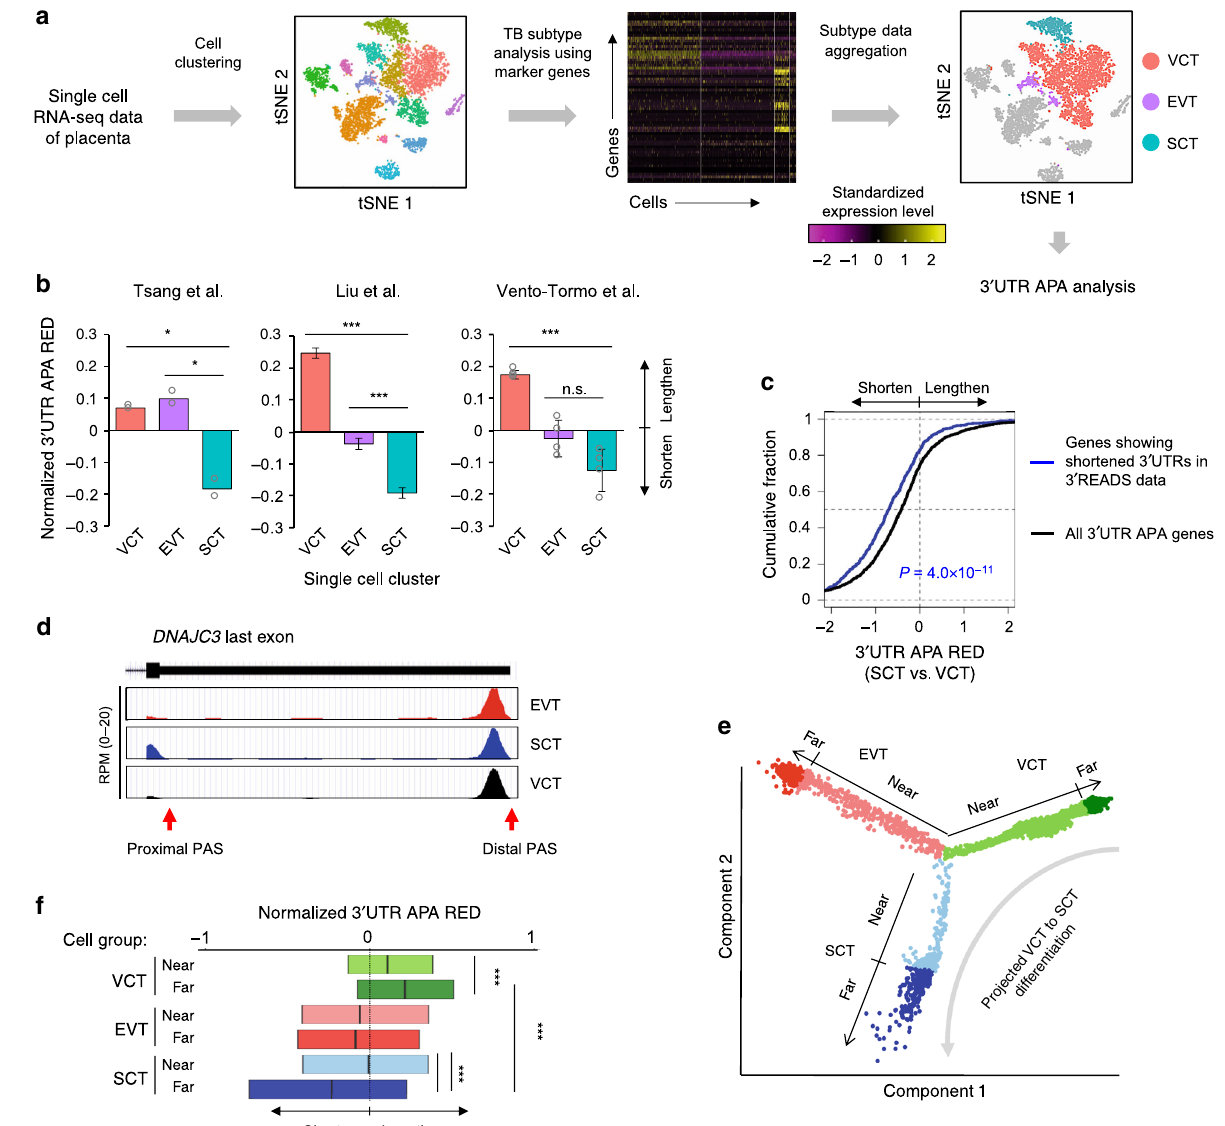
Fig. 4 Single-cell analysis reveals short 3 ʹ UTRs in SCTs. a Schematic of the single cell signi fi cance analysis of alternative polyadenylation (scSAAP) method. Cells are clustered by the Seurat package based on all gene expression values. The result is presented by the t-distributed stochastic neighbor embedding (tSNE) method. TB clusters are identi fi ed and grouped using the TB subtype marker gene panel. Data for each subtype are aggregated and treated as bulk RNA-seq data for 3 ʹ UTR APA analysis. b scSAAP analysis of placental single-cell RNA-seq datasets from three indicated studies. 3 ʹ UTR APA REDs of each dataset were normalized to the mean of all samples. Statistical signi fi cance is based on the Student ’ s t -test. Data are presented as mean value + / – SD (two replicates in Tsang et al. 29 , four replicates in Vento-Tormo et al. 30 , and 20 randomly sampled data in Liu et al. 36 ). c Cumulative